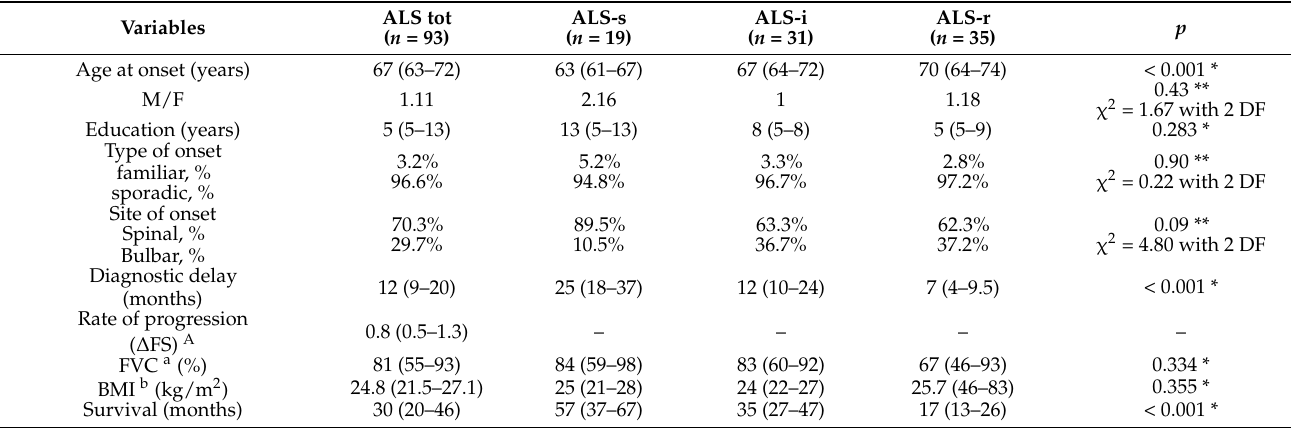
Table 1. Demographic and clinical characteristics of the total cohort and amyotrophic lateral sclerosis (ALS) patients stratified based on their rate of progression: slow (ALS-s), intermediate (ALS-i) and rapid (ALS-r). Data are expressed as a median with an interquartile range